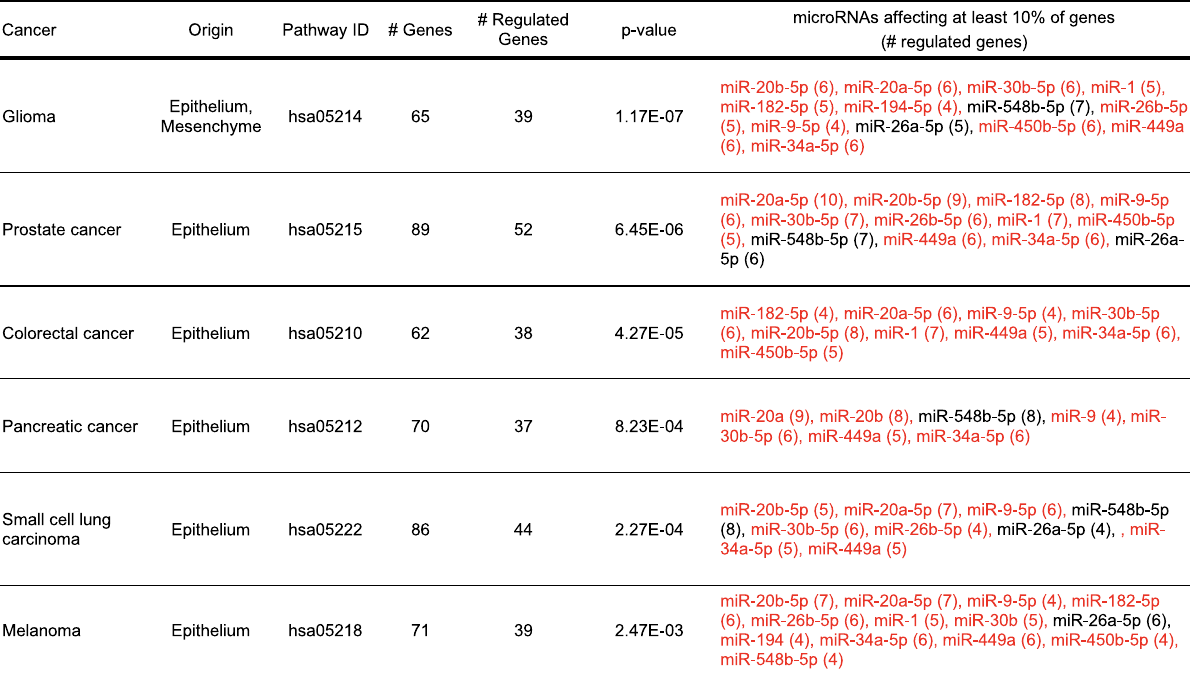
TABLE3| TheoverallchangeinmicroRNAsexpressionbyalcoholabusecouldleadtoseveralcancersofepithelialorigin.AnalysiswasperformedusingDIANAmirPathand KEGG software with FDR correction and a p -value threshold of 0.05. The top six cancers are shown. In fl ammatory microRNAs are marked